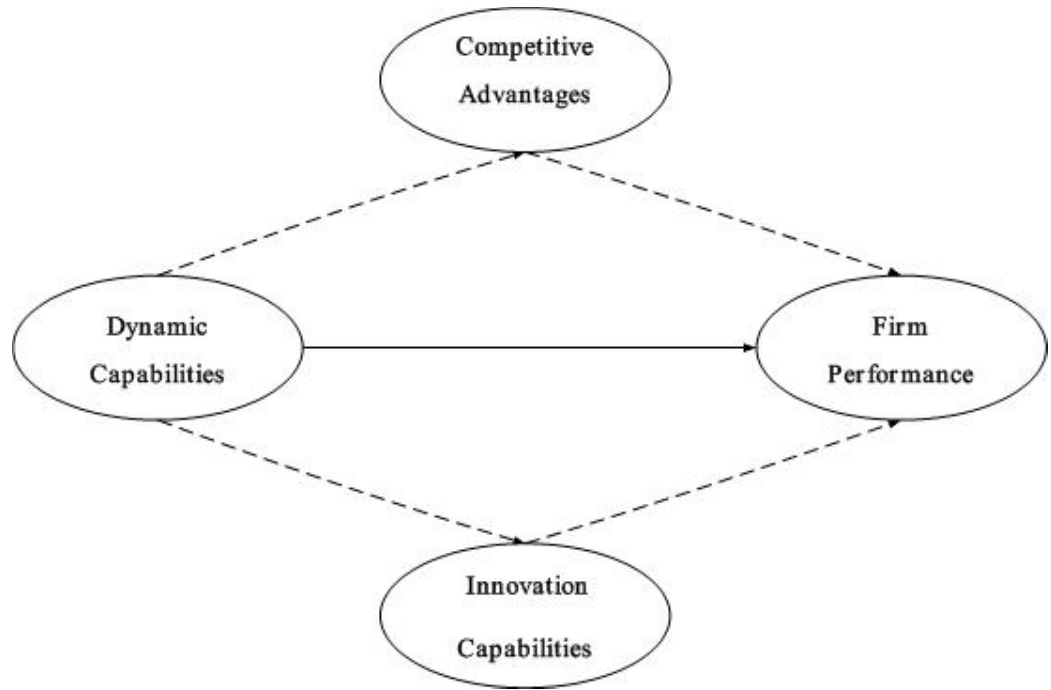
Figure 1. Conceptual research framework.